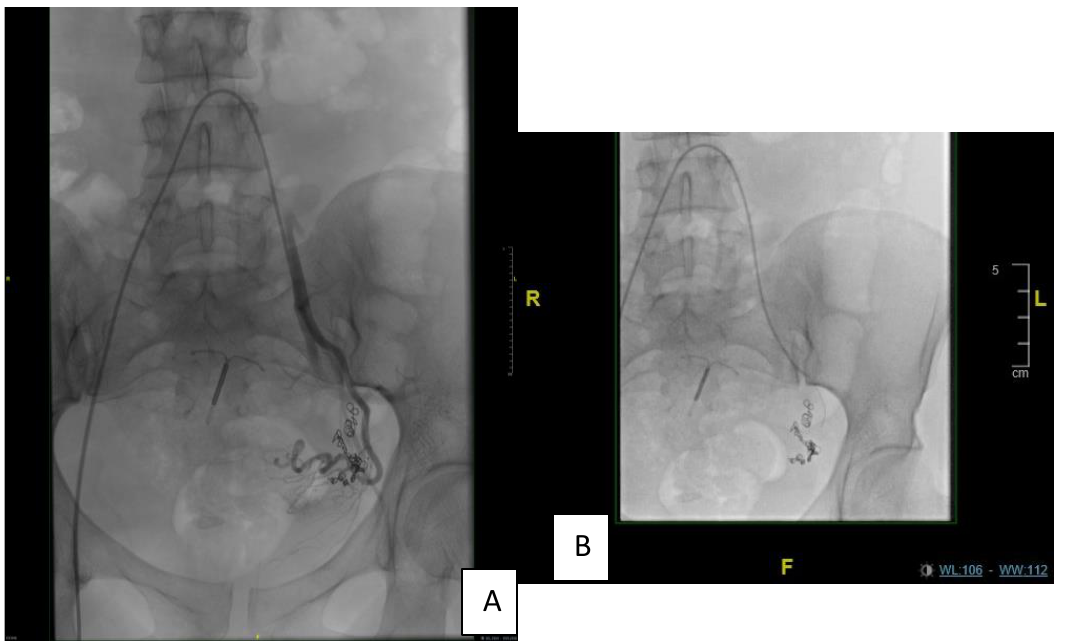
Figure 3. ( A , B ) Second Angio embolization showed total exclusion of the AVM without residual. The patient completed almost five years of follow-up—with regular ultrasonography every six months—without recurrence, hematuria, or lower urinary tract symptoms. During